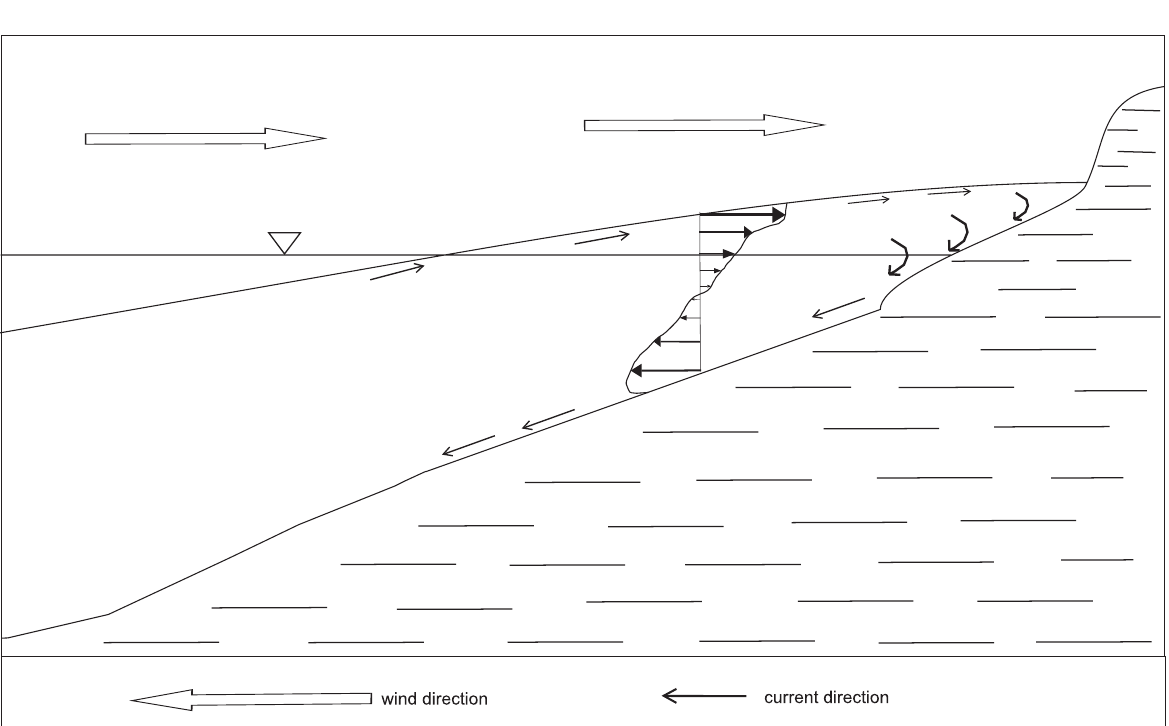
Fig. 11. Schema the inclination of the sea and the circulation of currents by the action of the wind field